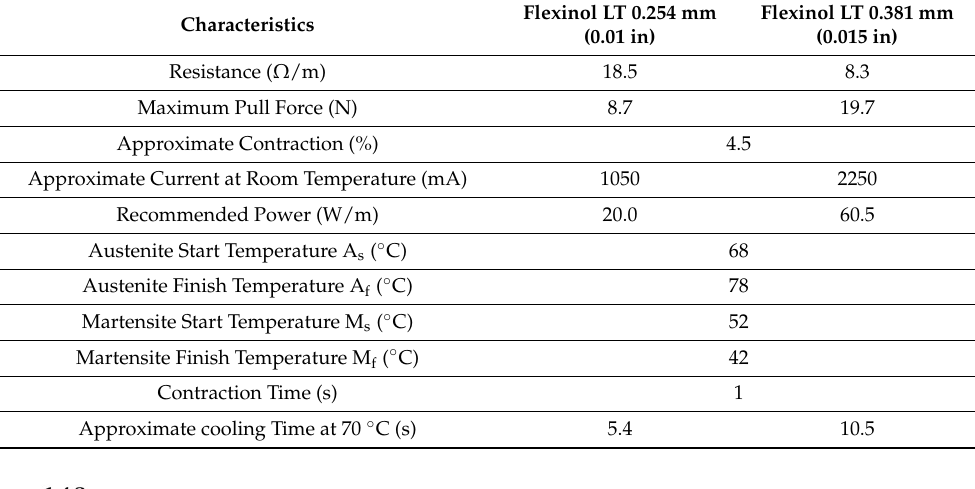
Table 2. Application-related characteristics of the SMA wire actuators used [14,26].